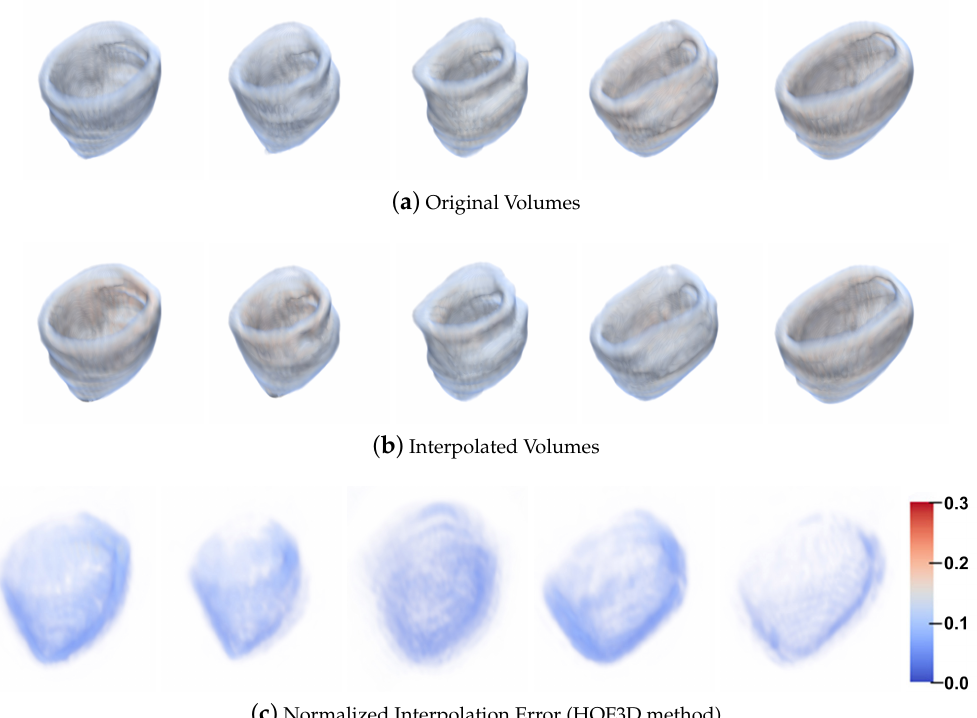
Figure 20. Left Ventricle from 30% to 70% of the cardiac cycle and the results with HOF3D